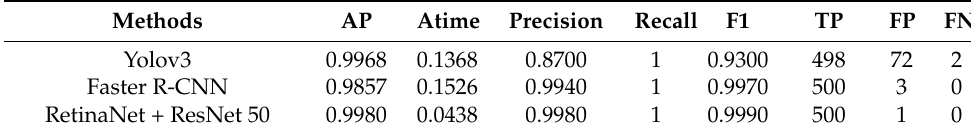
Table 2. Comparison of detection results with three competing